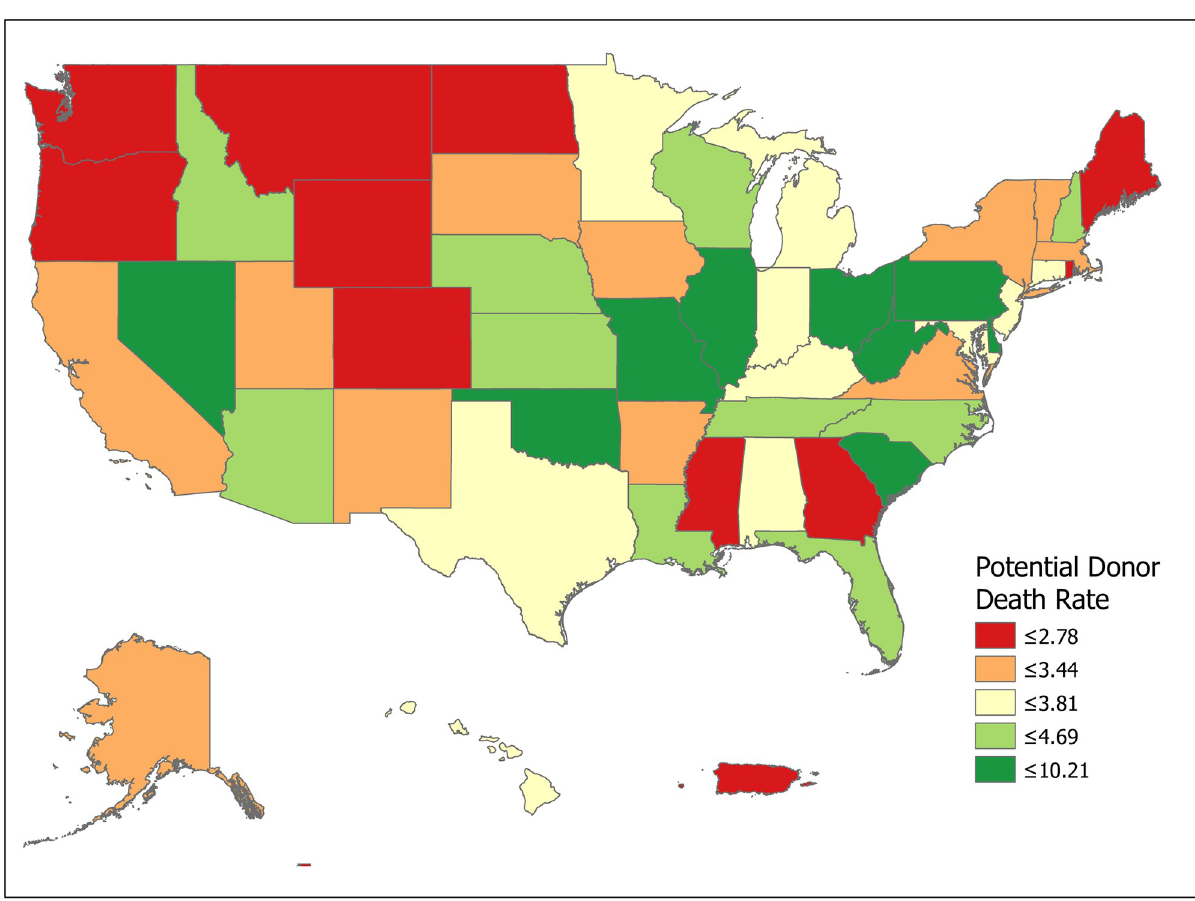
Fig 3. 2018 potential donor death rates, registered ( p 1 ). Data come from Tables 1 and 2. Maps created by ArcGIS Pro, URL: https://www.esri.com/en- us/arcgis/products/arcgis-pro/overview. Base Map: World Light Gray Base, URL: https://services.arcgisonline.com/arcgis/rest/services/Canvas.